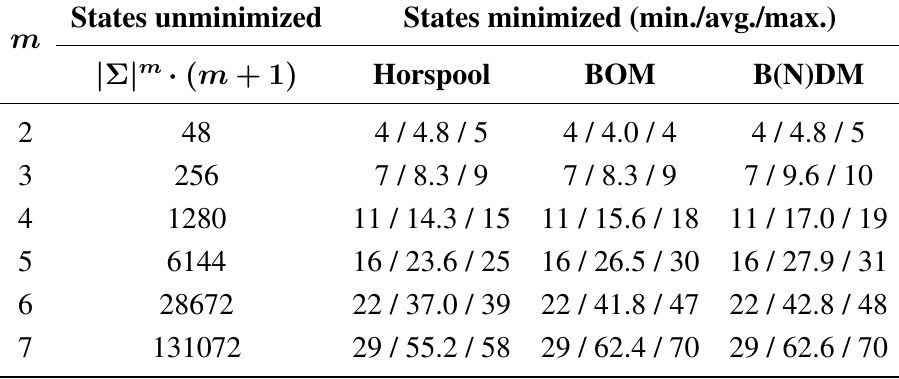
Table 1. Comparison of DAA sizes for all patterns of length m over Σ = { A , C , G , T } .